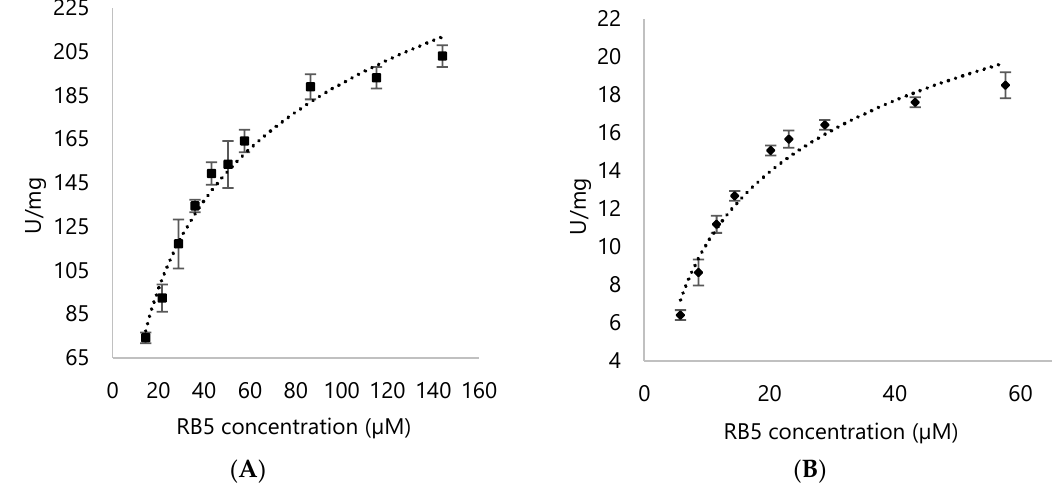
Figure 9. Michaelis-Menten kinetics of ( A ) DypA and ( B ) DypB with varying concentrations of Reactive Blue 5 (15 µM to 144 µM for DypA; 5 µM to 57 µM for DypB) in Reactive Blue 5 assay. Table 1. Steady-state kinetic parameters of DypA and DypB towards H 2 O 2 and Reactive Blue 5. Calculation of these parameters were based from the Michaelis-Menten fit from Figures 8 and 9.